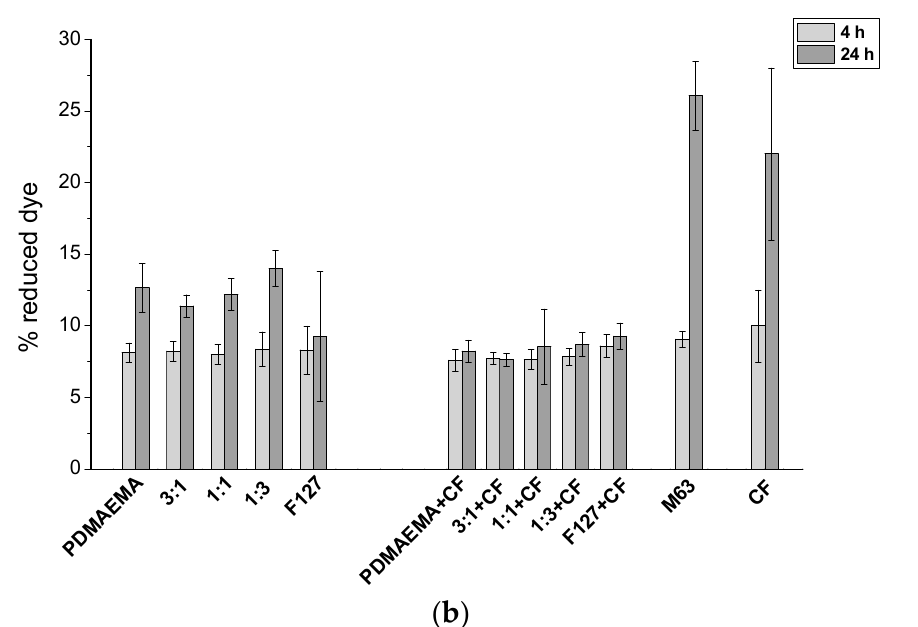
Figure 6. Metabolic activity of the biofilms of E. coli 25922 ( a ) and S. aureus 29213 ( b ) treated with SCPMs and MPMs based on PDMAEMA-b-PCL-b-PDMAEMA and Pluronic F127 triblock copolymers and represented as the capacity of the biofilms in the presence of the metabolic indicator Alamar blue to reduce resazurin to resoru fi n.